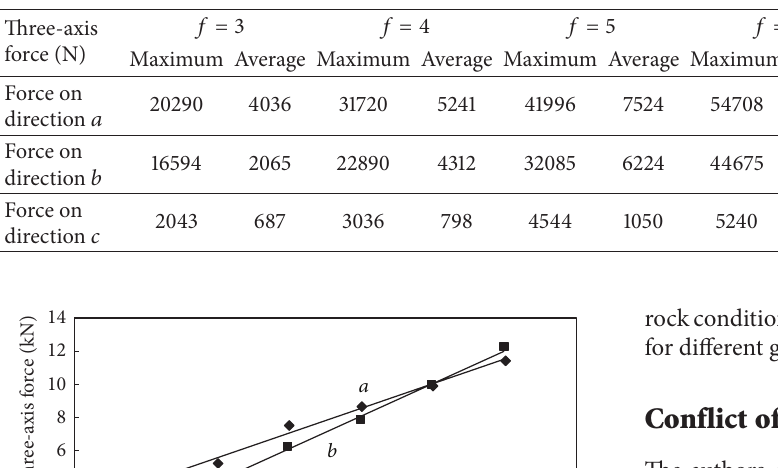
Table 4: Load statistics of cutting process with cutting head.